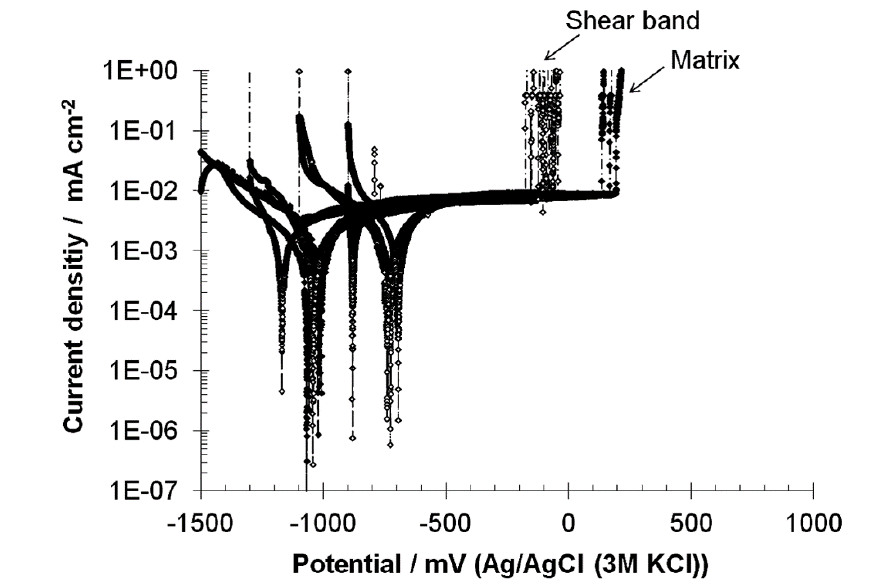
Figure 4. Potentiodynamic polarization curves measured on the shear bands and the